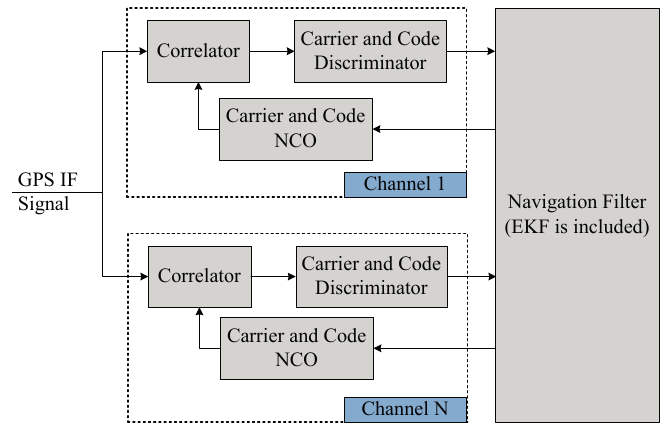
Figure 1. The architecture of the vector tracking